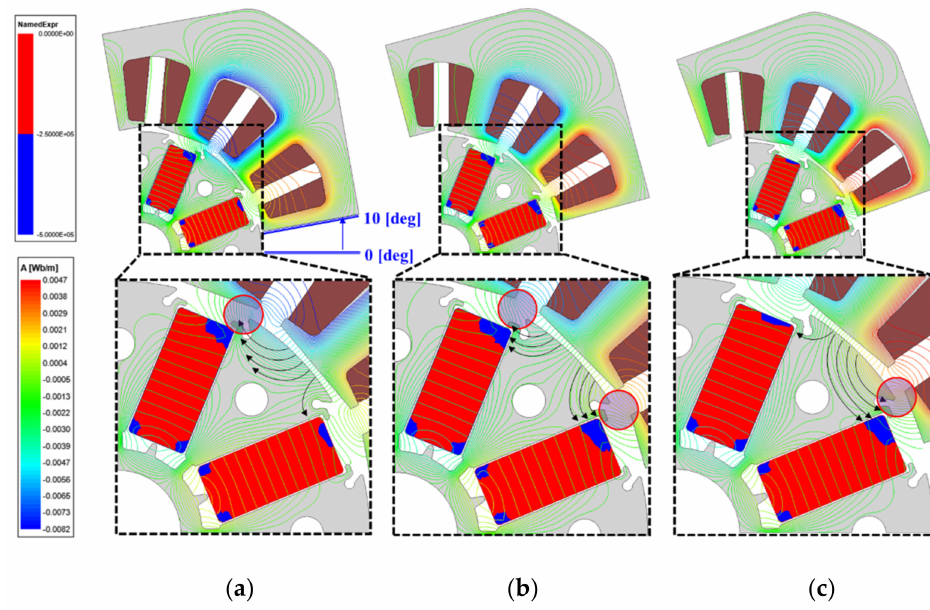
Figure 13. Irreversible demagnetization area of spoke-type PMSM. ( a ) 10 deg; ( b ) 15 deg; ( c ) 20 deg.